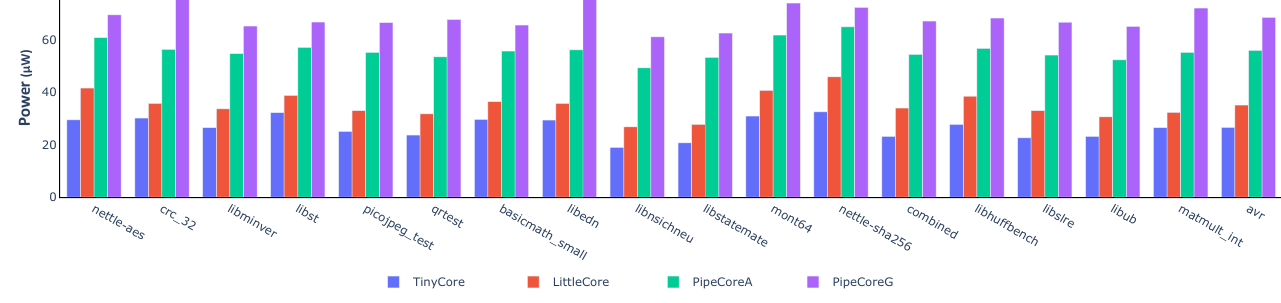
Figure 4. Power consumption of baseline processors.